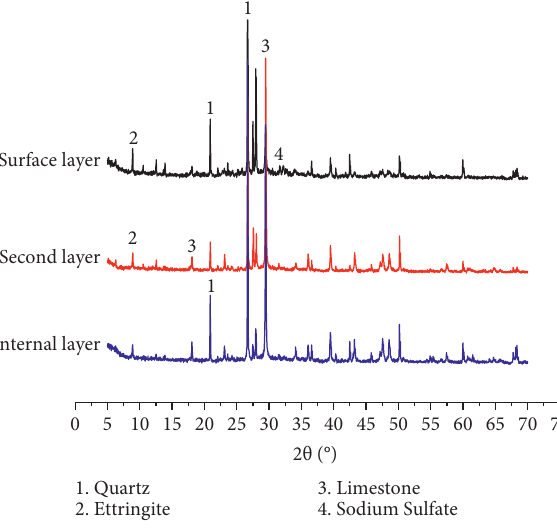
Figure 13: XRD patterns at different depths for specimen N10G1.